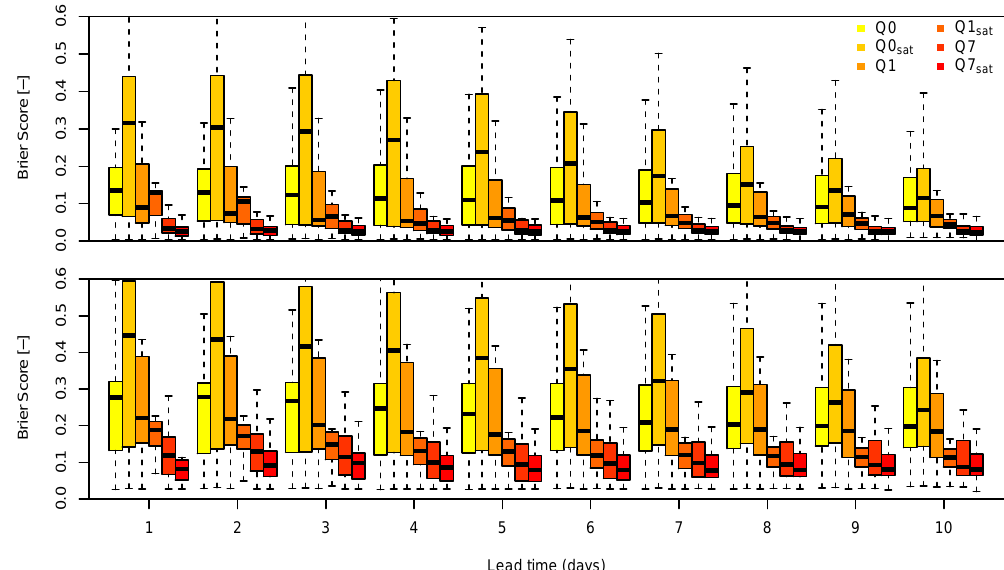
Figure 8. BS for different forecasting times for EFAS in the Upper Danube (Fig. 1). Each box only contains the BS for the 16 validation locations for a period of 1year with two forecasts per day. The Brier scores for the 90% threshold (top) and the 80% threshold (bottom) are given. A total of 1035 and 2070 time steps (90th and 80th percentiles, respectively) with flooding were observed for the Upper Danube.